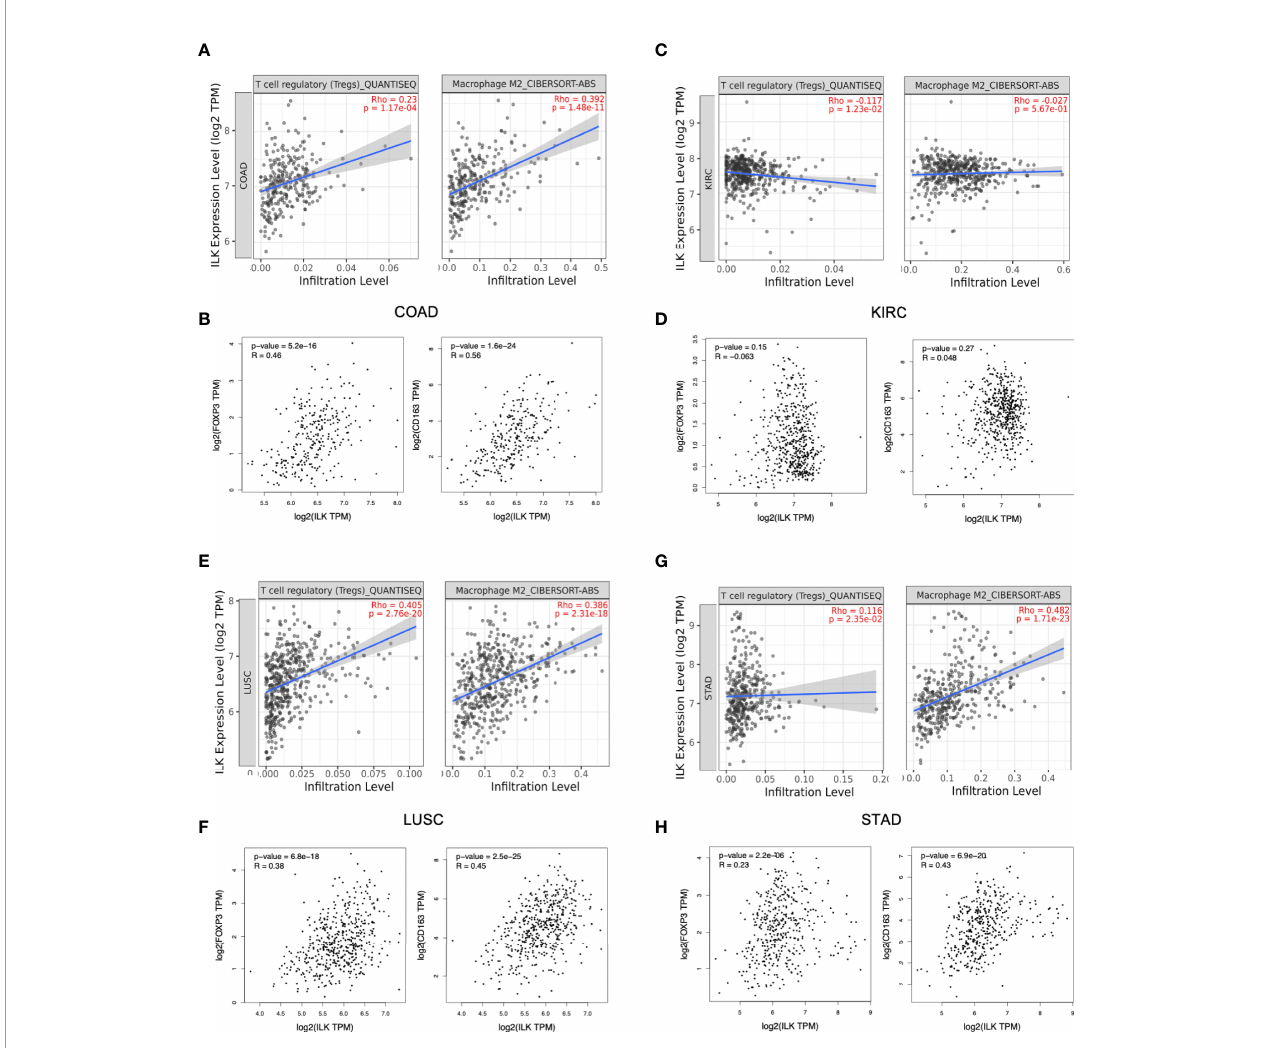
FIGURE 6 | ILK expression is correlated with Tregs and M2 macrophages in fi ltration and their gene markers in COAD, LUSC and STAD. (A, C, E, G) ILK expression correlation with Tregs and M2 macrophages in fi ltration in COAD, KIRC, LUSC and STAD via TIMER platform. (B, D, F, H) Gene markers for M2 macrophage (CD163), Treg cells (FOXP3) and their correlation with ILK in COAD, KIRC, STAD and LUSC via GEPIA. QUANTISEQ and CIBERSORT-ABB are different methods used via TIMER for cell quanti fi cation based on gene expression. Since most immune cells are negatively correlated with tumor purity, the correlation is adjusted by purity partial spearman ’ s correlation rho. R is Spearman ’ s correlation Rho value. The signi fi cant P -value is